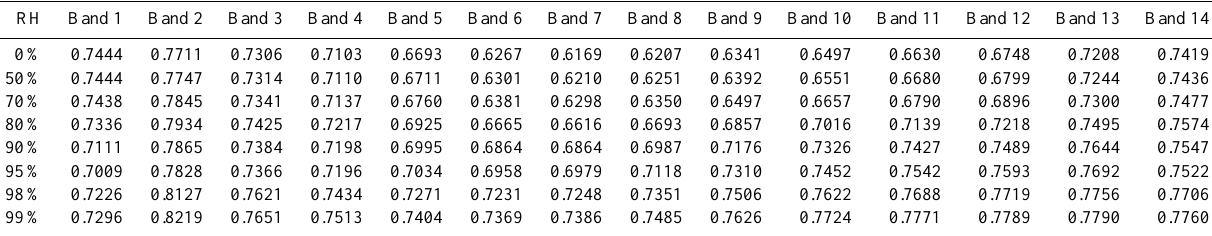
Table A5. Asymmetry parameter for the rural aerosol mixture. RH